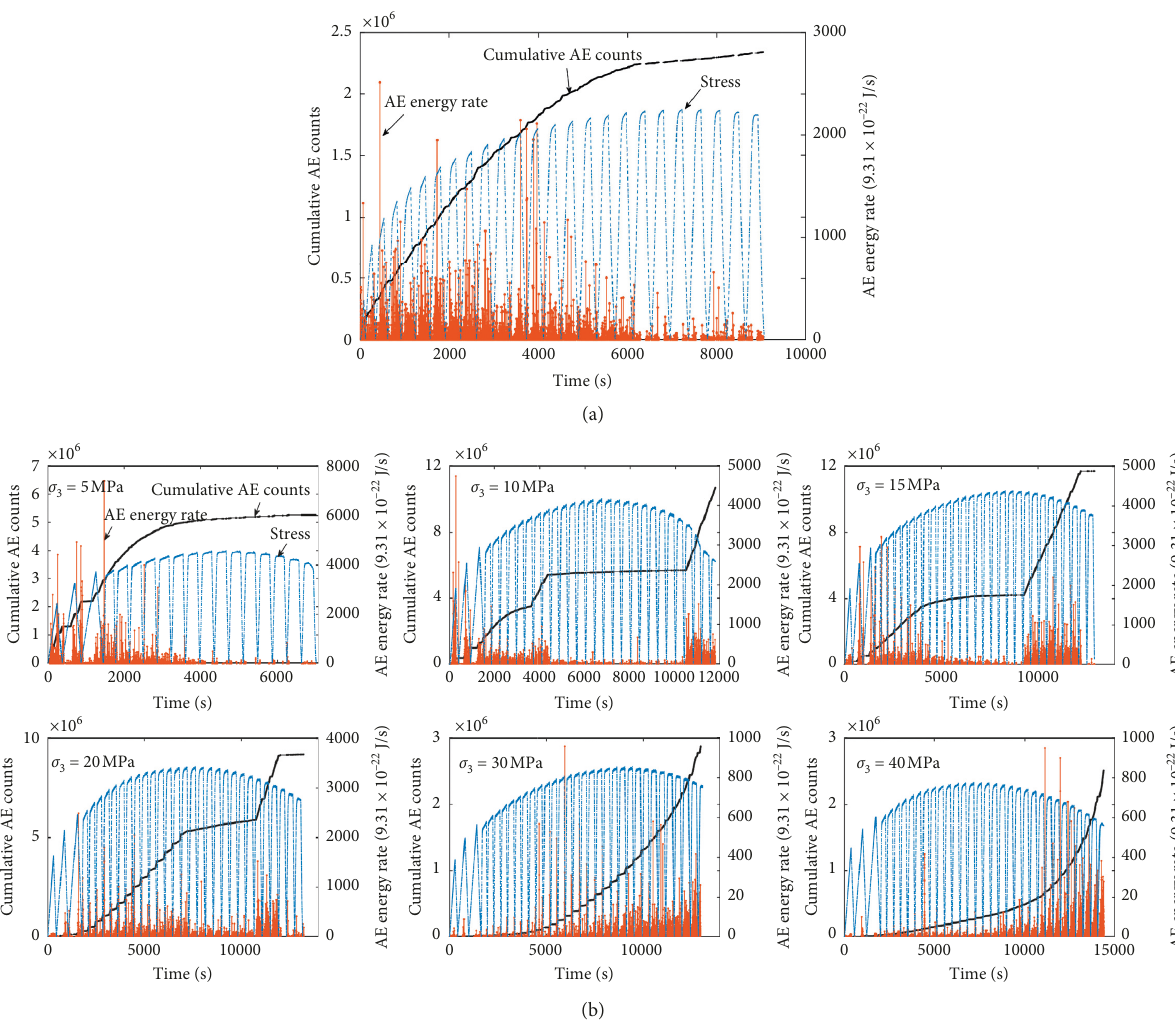
Figure 7: Variations of cumulative AE counts and AE energy rates in compression tests. (a) Uniaxial compression test. (b) Triaxial compression